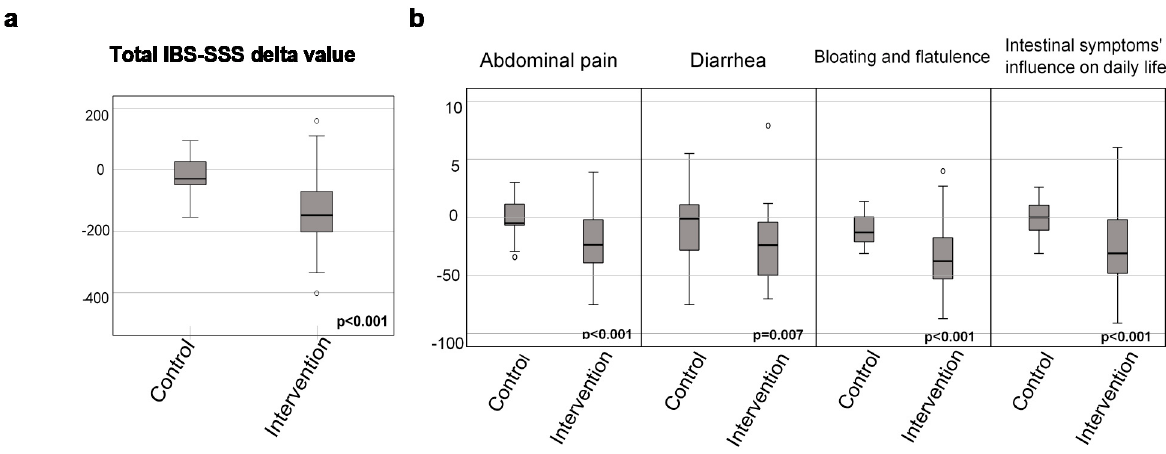
Figure 2. Boxplots representing change in ( a ) total irritable bowel syndrome-symptom severity score (IBS-SSS) [23] and ( b ) visual analog scale for irritable bowel syndrome (VAS-IBS) [24] for the intervention group and controls after the starch- and sucrose-reduced dietary intervention study. Mann–Whitney U test. p < 0.05 was considered statistically significant.